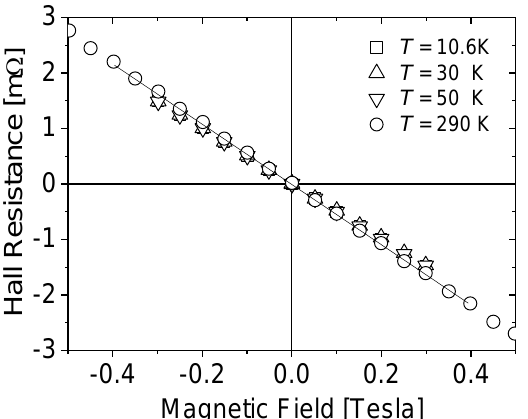
Figure 1. The Hall resistance R = V H / I s vs. magnetic field B at T = 10.6 K, 30 K, 50 K and at room temperature ( T = 290 K). Results for sample H1. temperature ( T = 290 K). Results for sample H1.